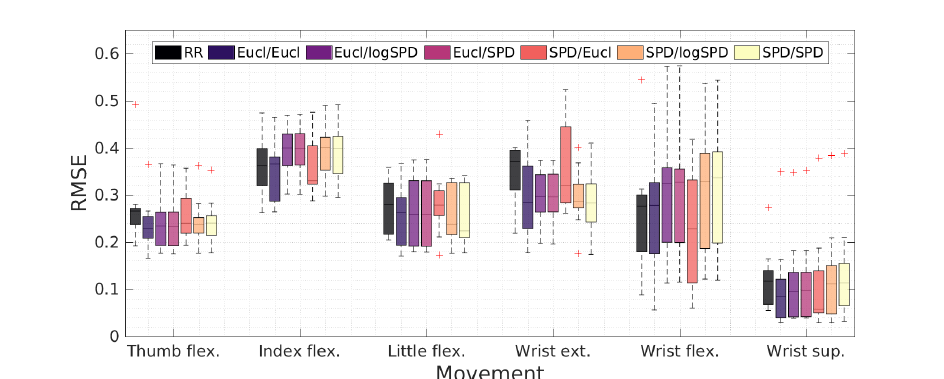
Figure 11. Comparison of the root-mean-square error (RMSE) between Gaussian process regression (GPR) using different kernel distances to combine surface electromyography (sEMG) and tactile myography (TMG) as input for the different movements executed by the participants.